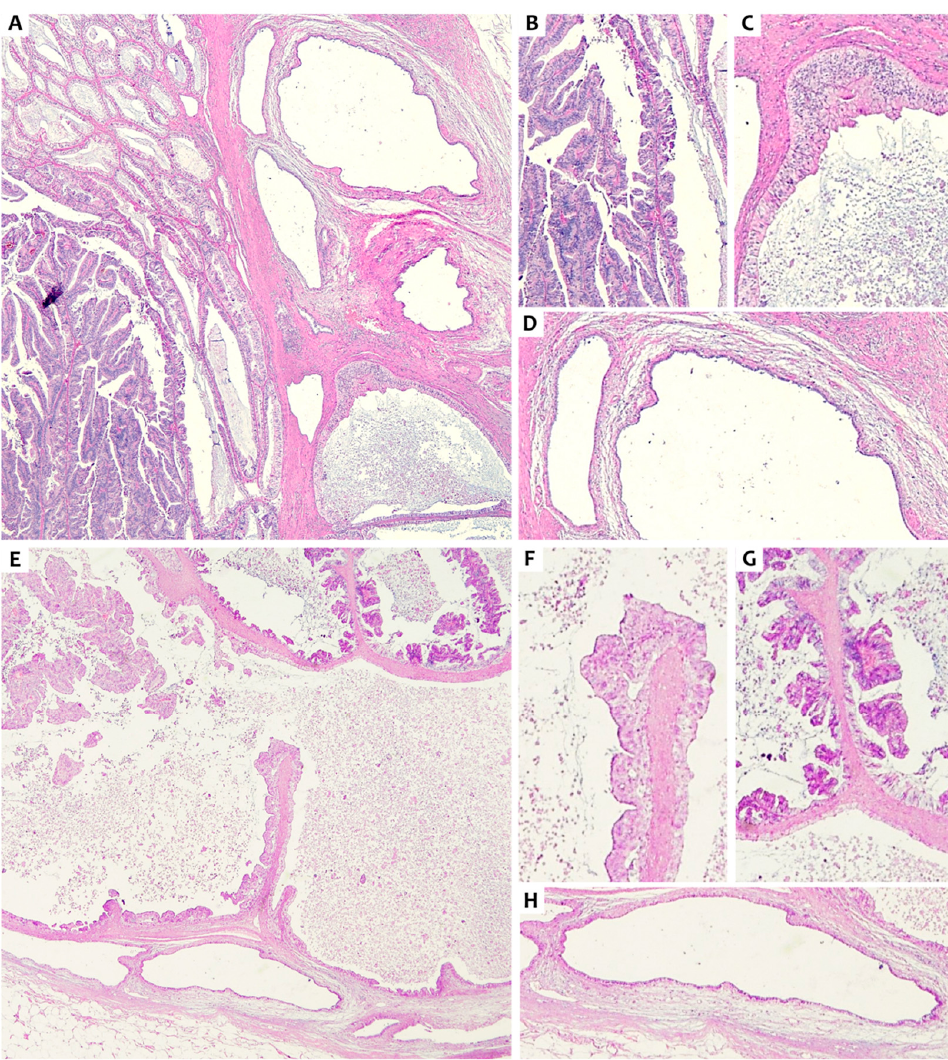
Figure 2. Histopathological images of case #1, demonstrating an intracholecystic papillary neoplasm (ICPN) involving Rokitansky-Aschoff sinuses (RAS). Images on the left ( A , E ) display the findings at lower magnification; images on the right ( B – D , F – H ) display the corresponding details. The images show a dysplastic/neoplastic epithelium ( B ) that involves the RAS mucosa ( C ) and exhibits a papillary growth pattern ( F , G ). Other RAS are spared by the tumor and show typical benign features ( D , H